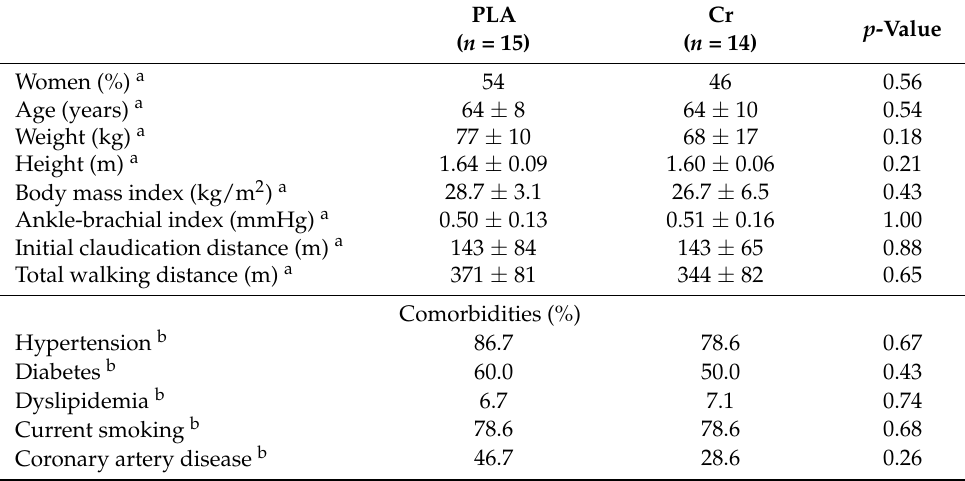
Table 1. Characteristics of participants at baseline ( n =